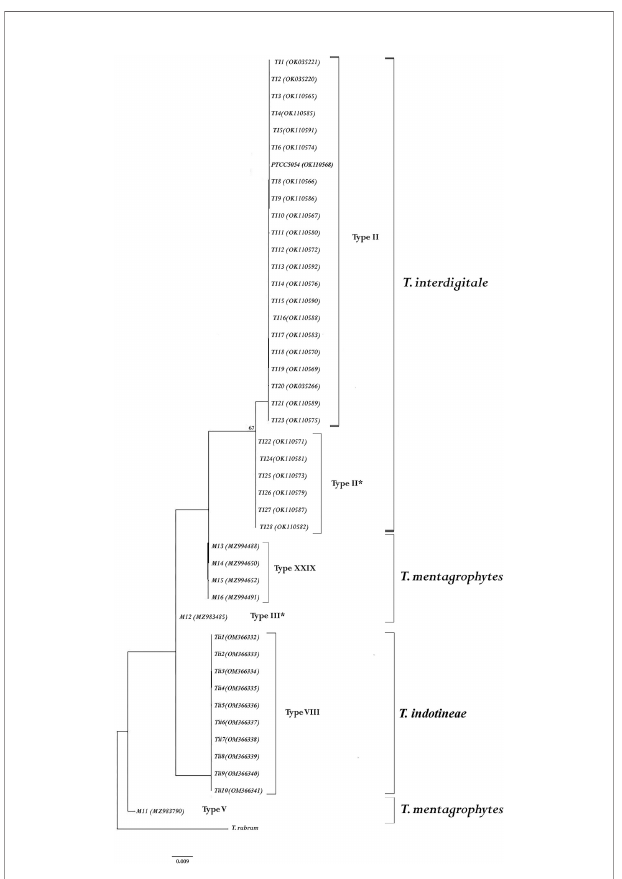
FIGURE 1 | The genotyping tree was constructed based on ITS region sequences by RAxML analysis from Trichophyton mentagrophytes/ Trichophyton interdigitale complex, and the accession numbers are given in parentheses . Trichophyton rubrum was used as an outgroup to root the dendrogram. The bootstrap value greater than 65% is shown above the